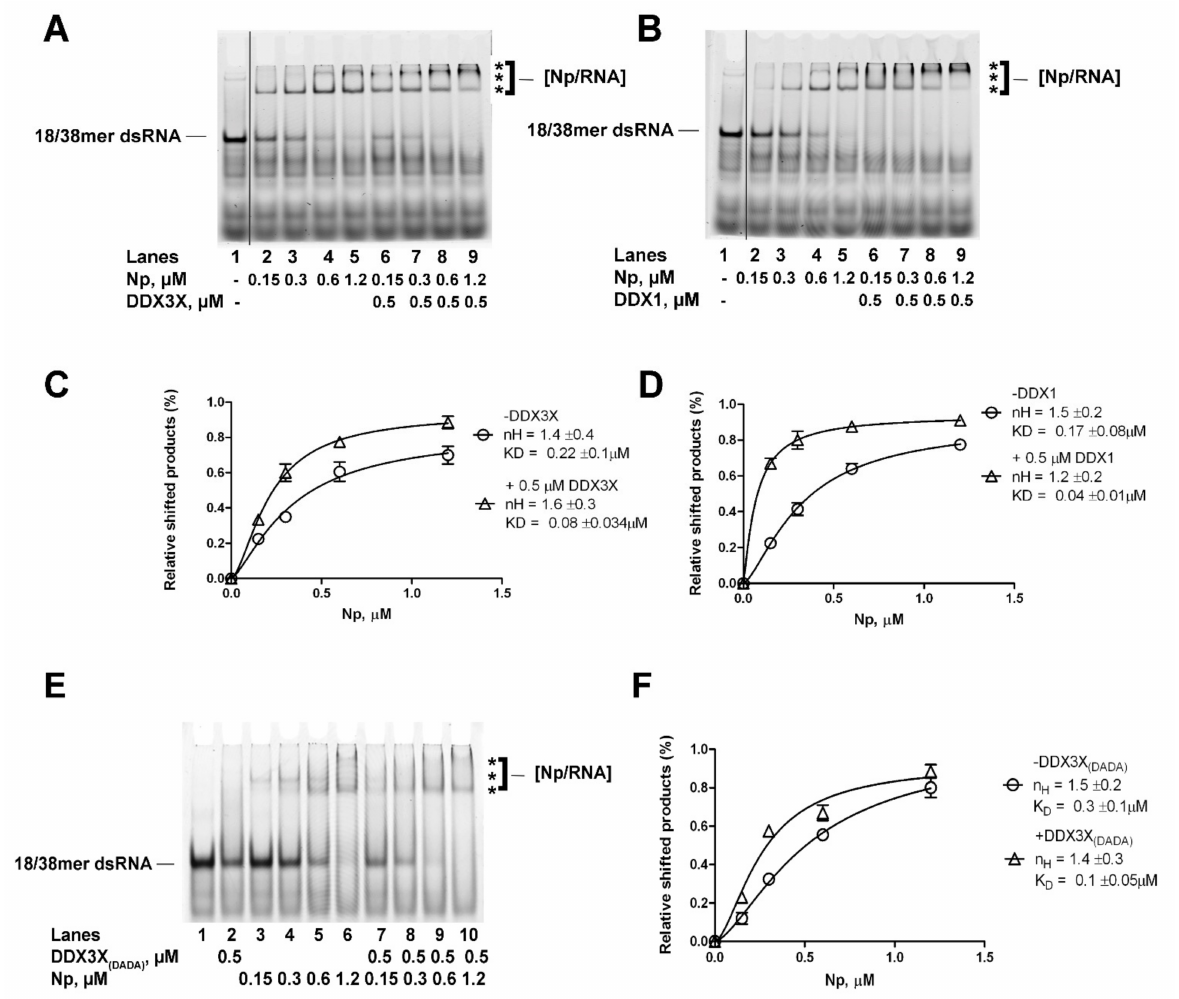
Figure 6. DDX1 and DDX3X increase the affinity of SARS-CoV-2 Np protein for dsRNA. Asterisks (***) in all panels indicated the high molecular weight Np–dsRNA complexes. ( A ). EMSA showing the titration of Np in the presence of dsRNA and in the absence (lanes 2–5) or in the presence (lanes 6–9) of DDX3X. Lane 1, control in the absence of proteins. ( B ). As in panel A, but with DDX1 replacing DDX3X. ( C ). Np–dsRNA complex formation as a function of Np concentrations in the absence (circles) or in the presence (triangles) of DDX3X. Curves were fitted according to a cooperative model with the software GraphPad Prism 6.0. Data points represent the mean of two independent experiments ± S.E. ( D ). As in panel C but with DDX1 replacing DDX3X. ( E ). EMSA showing the titration of Np in the presence of dsRNA and in the absence (lanes 3–6) or in the presence (lanes 7–10) of the catalytically dead mutant DDX3X (DADA) . Lane 1, control in the absence of proteins. Lane 2 control in the presence of DDX3X (DADA) alone. ( F ). Np–dsRNA complex formation as a function of Np concentrations in the absence (circles) or in the presence (triangles) of the catalytically dead mutant DDX3X (DADA) . Curves were fitted with the software GraphPad Prism 6.0 according to a cooperative model. Data points represent the mean of two independent experiments ±